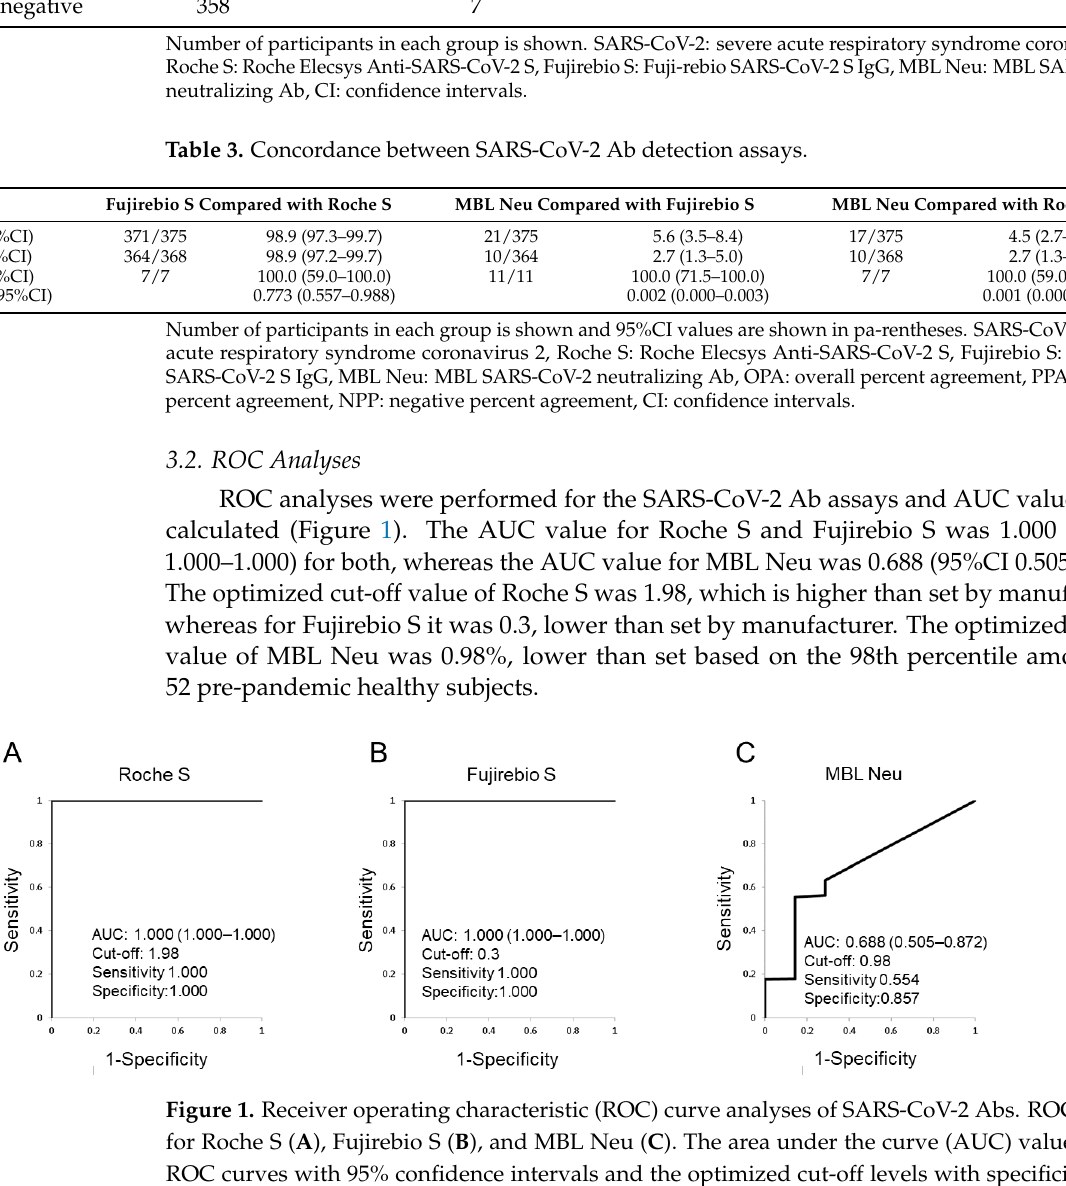
Table 2. Clinical performance of SARS-CoV-2 Ab assays.